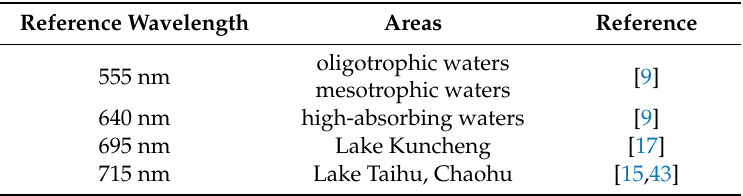
Table 1. Reference wavelengths from di ff erent cases of waters.